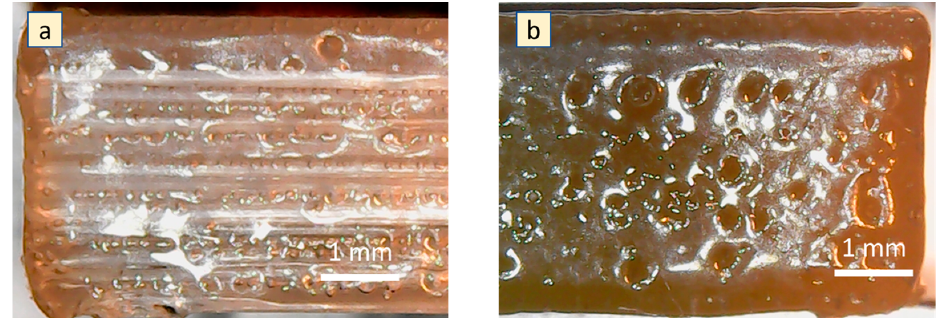
Figure 2. ( a ) Parallel cutting, ( b ) perpendicular cutting.